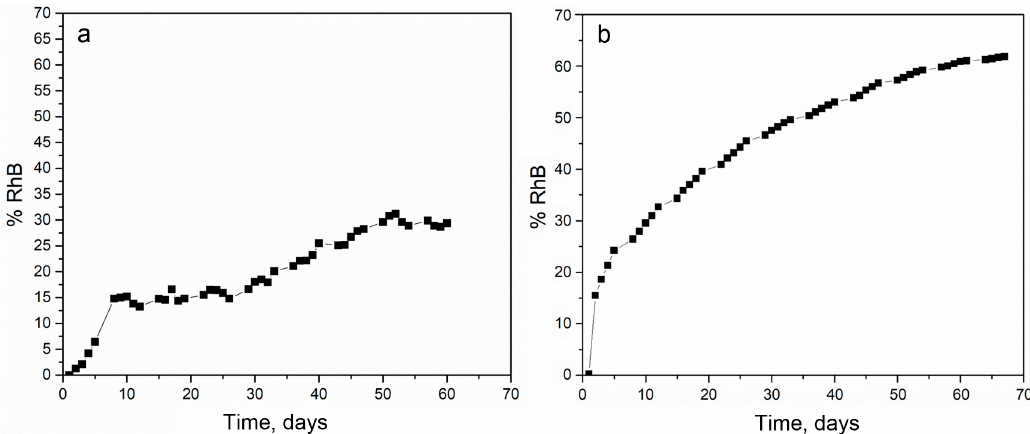
Figure 2. The experimental release of Rhodamine B (RhB) from poly( D , L -lactide-co-glycolide) PLGA 1 ( a ) and PLGA 2 ( b ) nanofiber